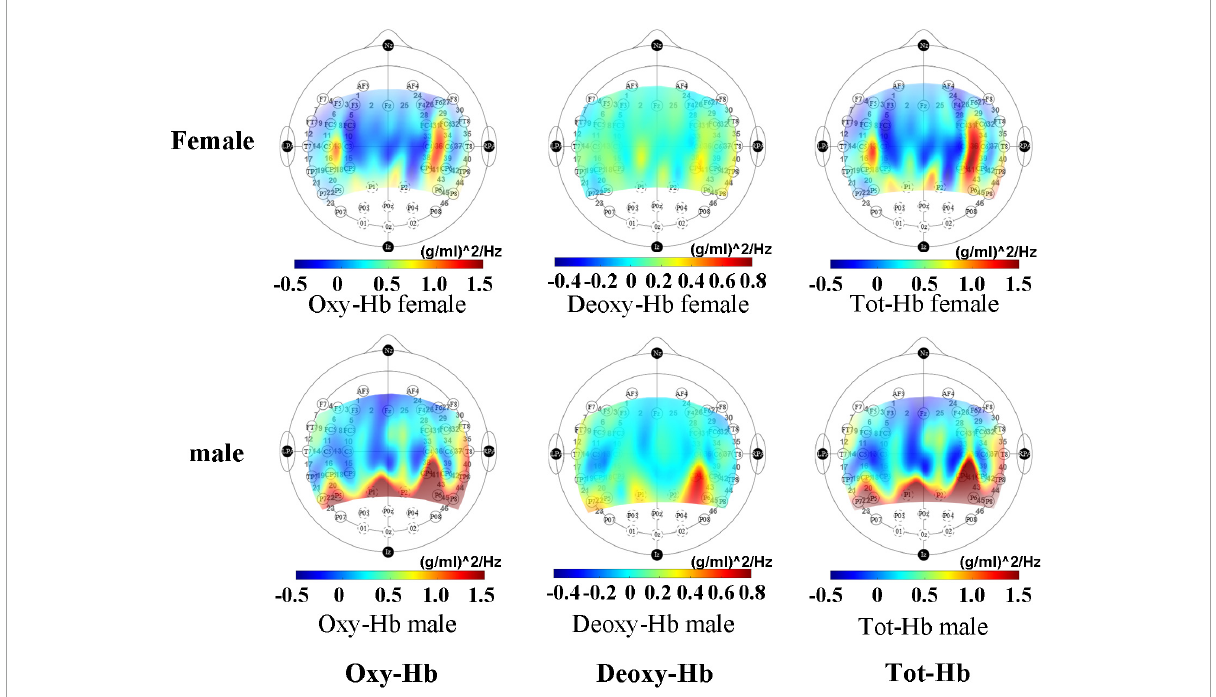
FIGURE2 Mean activation maps of female and male infants under non-tasks measured by